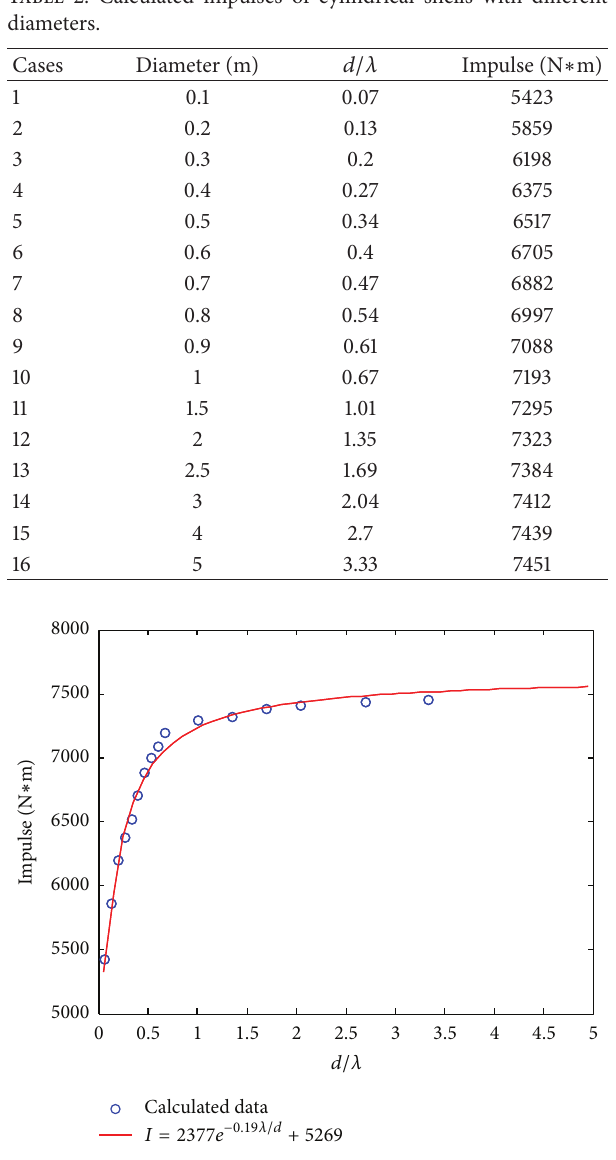
Figure 5: Schematic diagram of regression curve.